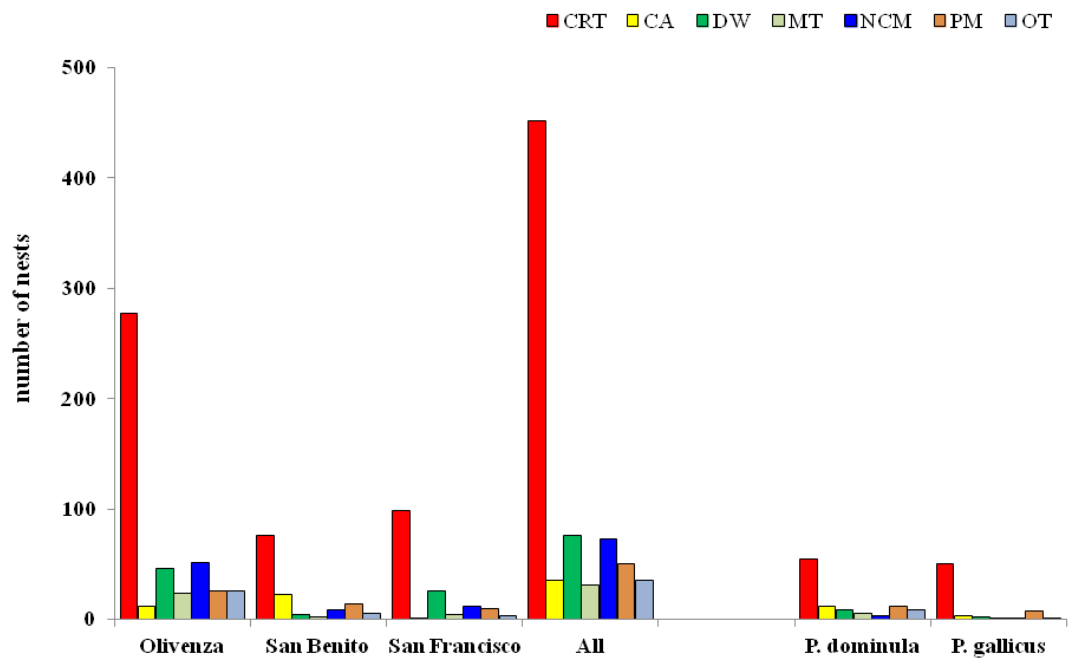
Fig 1 . Type of substrate selected by wasps in each city and by species (clay roof tile, CRT; corrugated asbestos, CA; direct on wall, DW; metal tubes, MT; non-cylindrical metallic structures, NCM; plant material, PM; others,